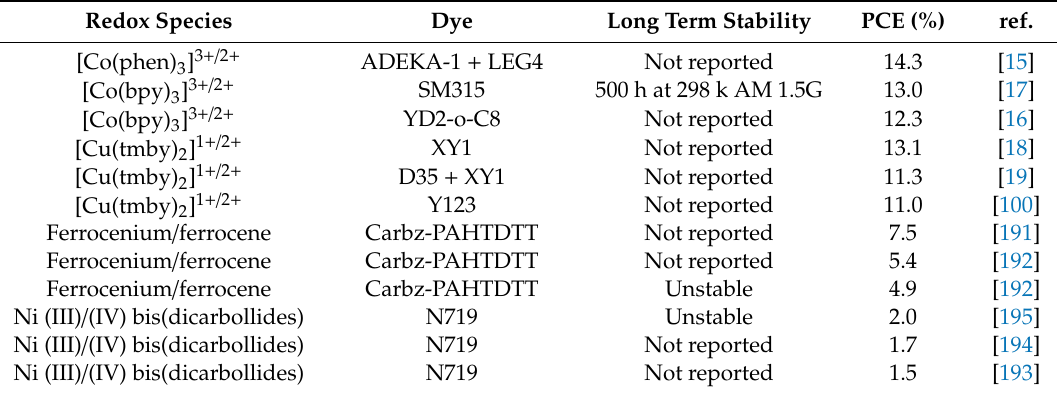
Table 4. Best e ffi ciencies reported for electrodes based on alternative redox species. Redox Species